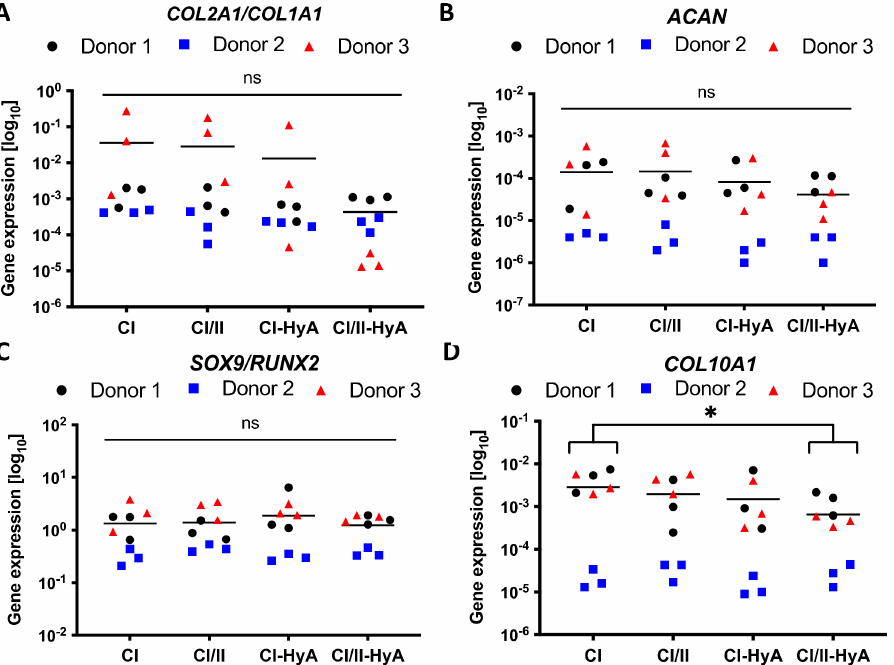
Figure 7. All collagen scaffolds supported the expression of genes associated with effective human MSC chondrogenic differentiation, with reduced expression of COL10A1 gene in composite CI/II- HyA scaffolds. The expression of ACAN ( B ) and COL10A1 ( D ) genes was determined after 28 days in culture, normalised to 18S and then converted to relative gene expression using the formula: Fold increase = 2ˆ( − ∆ Ct). The ratios between COL2A1 / COL1A1 and SOX9 / RUNX2 genes are shown in ( A , C ). Data shown represent the grand mean from three individual human MSC donors n = 3. * denotes p ≤